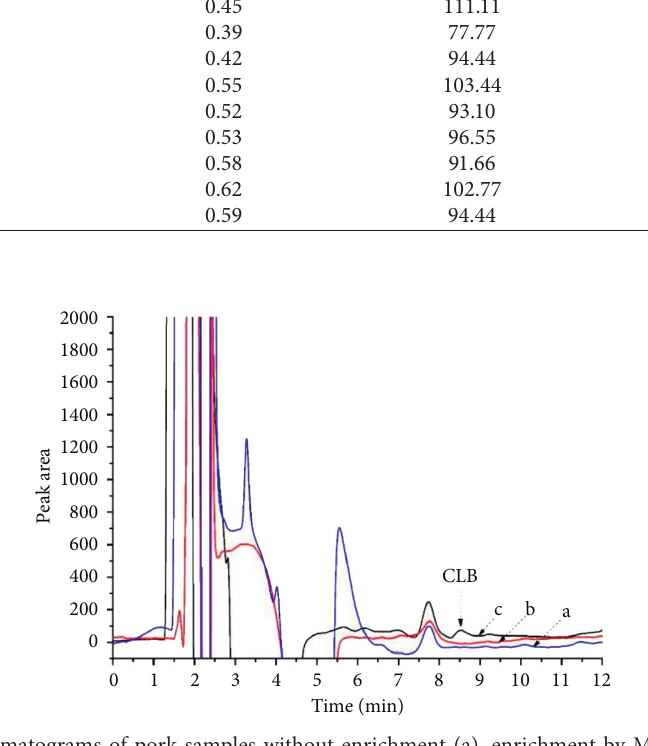
Figure 7: The standard curve with linear regression. Table 2: Accuracy of the method for sample solutions spiked at different concentrates ( n � 3). Samples